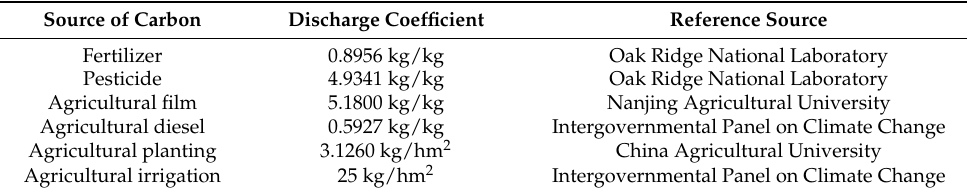
Table 1. Sources and coefficients of carbon emissions in the planting